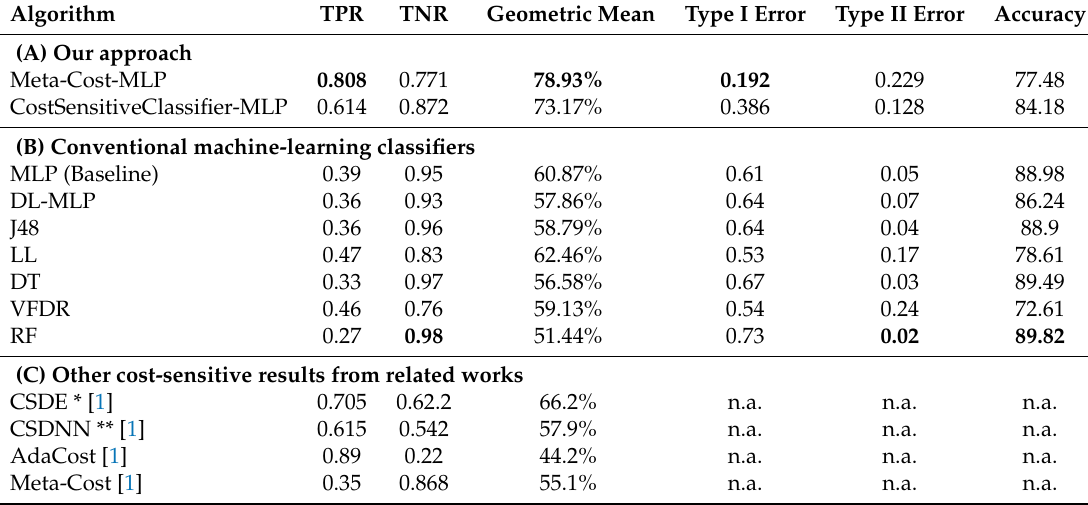
Table 7. Performance Comparison of Different Classification